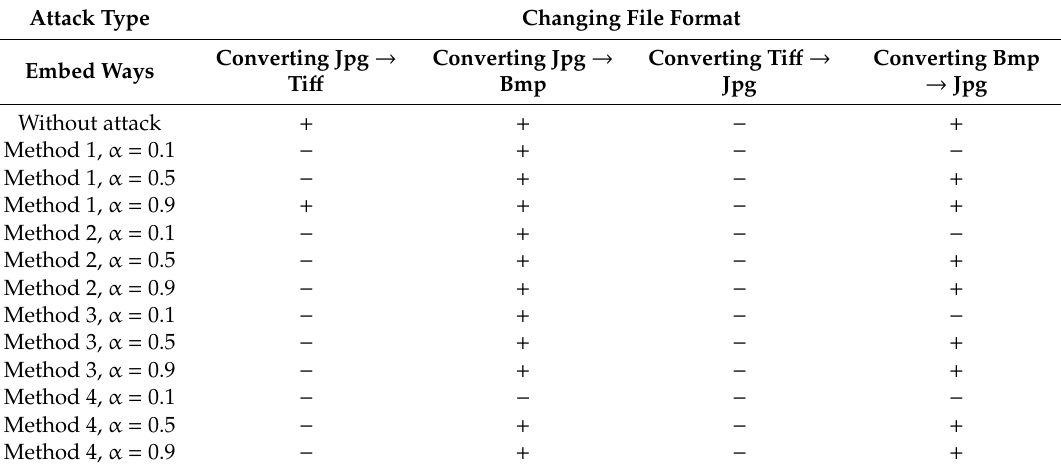
Table 5. The results of the experiments of the conducted attacks of the type of format conversion to verify the e ff ectiveness of the method on the example of the test image “Lena” by Equation (34) m = 1, n = 7.